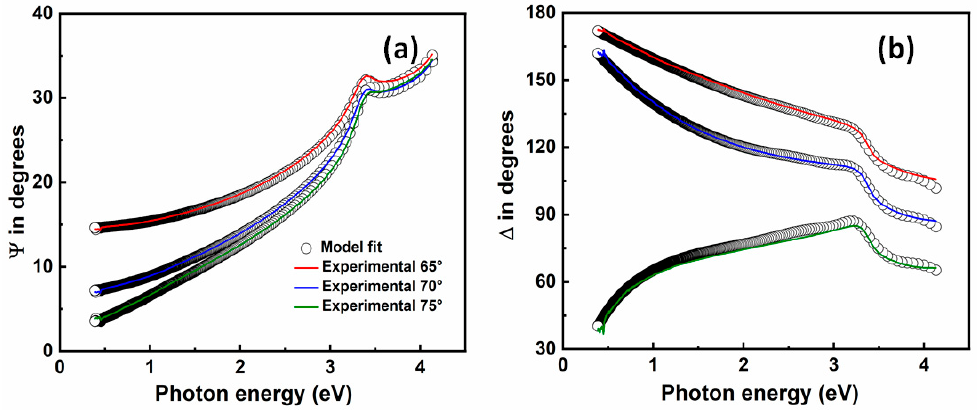
Figure 4. Variable angle spectroscopic ellipsometry measurements of graphene oxide films on SiO 2 /Si substrates. Experimental and model generated ψ ( a ) and ∆ ( b ) data fits at di ff erent angles of incidence.